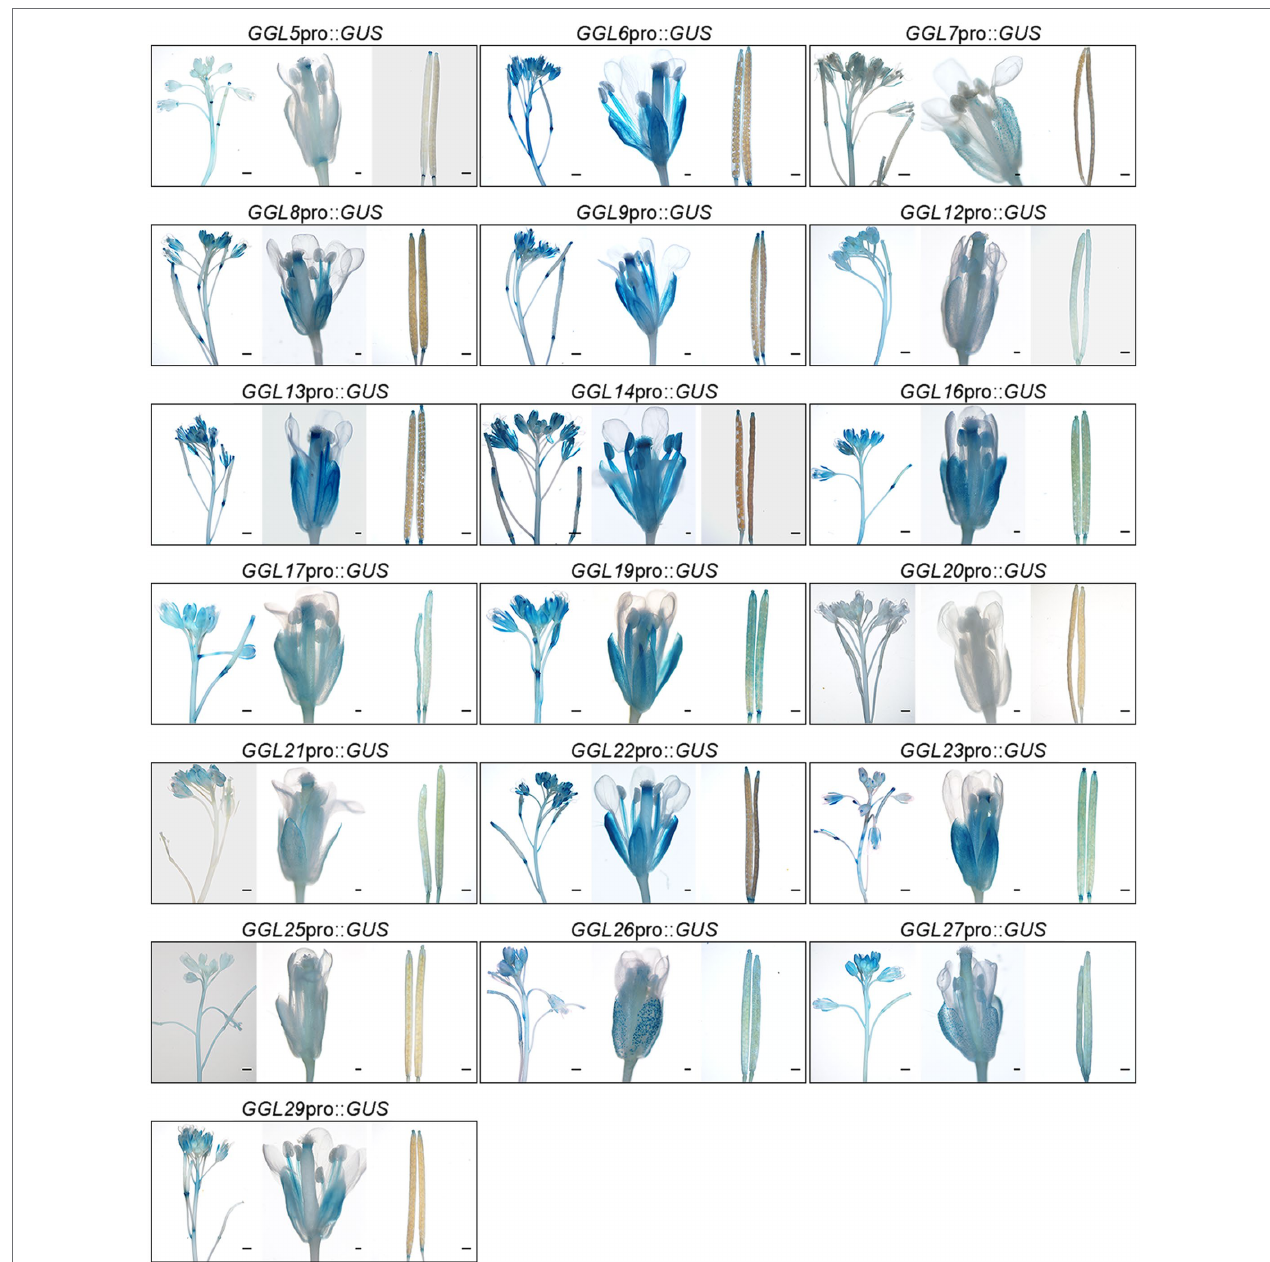
FIGURE 4 | Expression patterns of 19 GGLs at reproductive stage. The tissues from 34-DAG GGL pro:: GUS expressing plants were stained with X-Gluc. For each gene, the images from left to right represent an inflorescence from a 34-DAG plant (scale bar = 100 μ m), a mature flower from a 34-DAG plant (scale bar = 1 mm), and mature siliques from a 34-DAG plant (scale bar = 100 μ m),